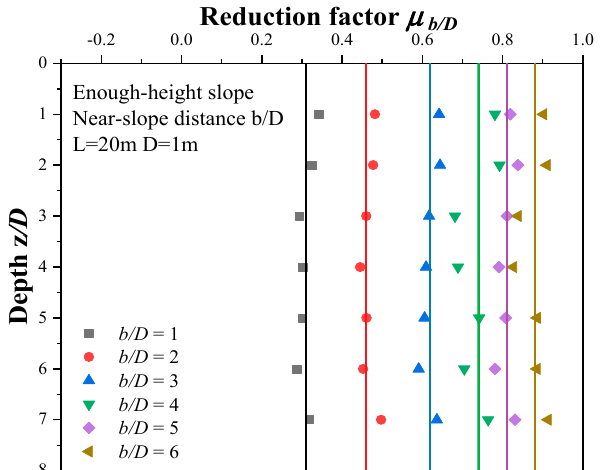
Figure 5. Effect of b / D on µ b / D by deriving the results of FEA for θ = 90 ◦ .